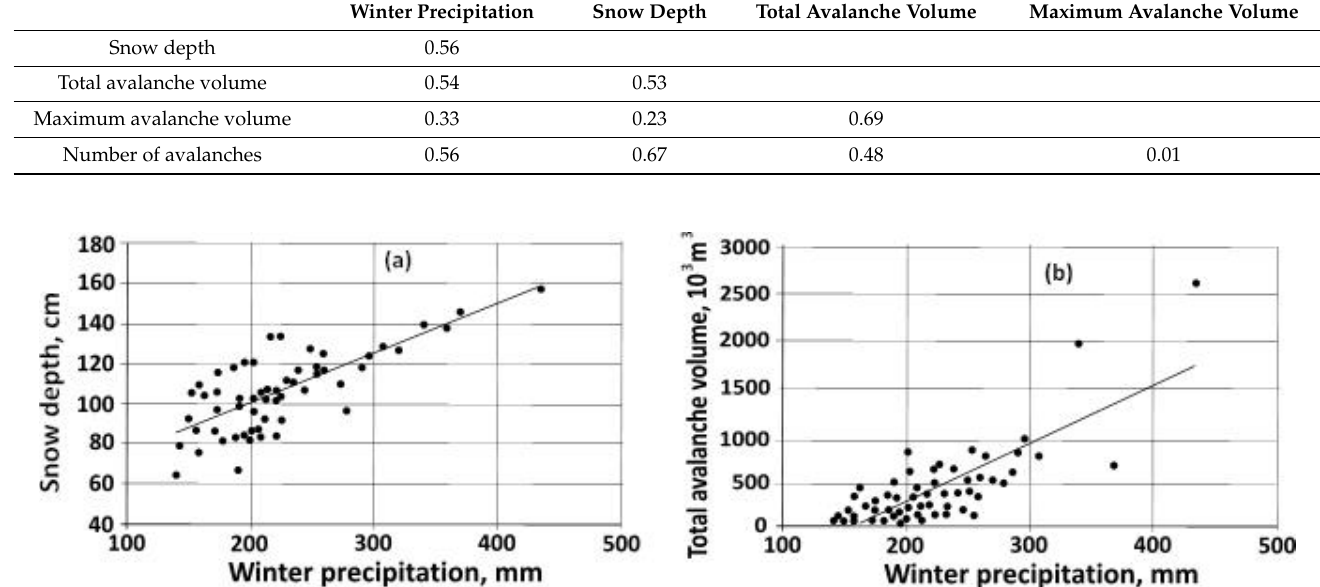
Table 1. The Spearman’s correlation coefficients between snowiness and avalanche activity indices.